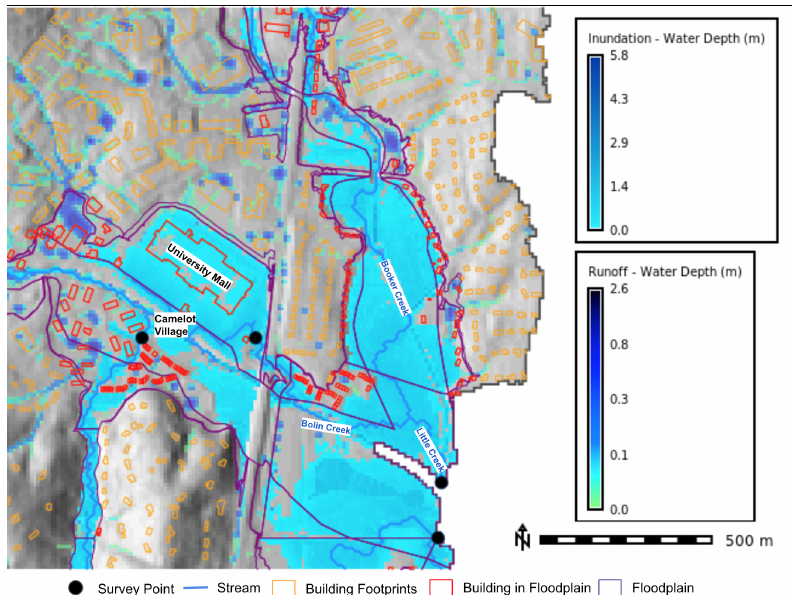
Figure 11. Cluster 1—University Mall and Camelot Village are shown inside the floodplain and flooded during a simulated 100-year precipitation event. Surface water runoff accumulated to depths up to 2.6 m, and the one-meter inundation extent shows that the locations are prone to flooding.